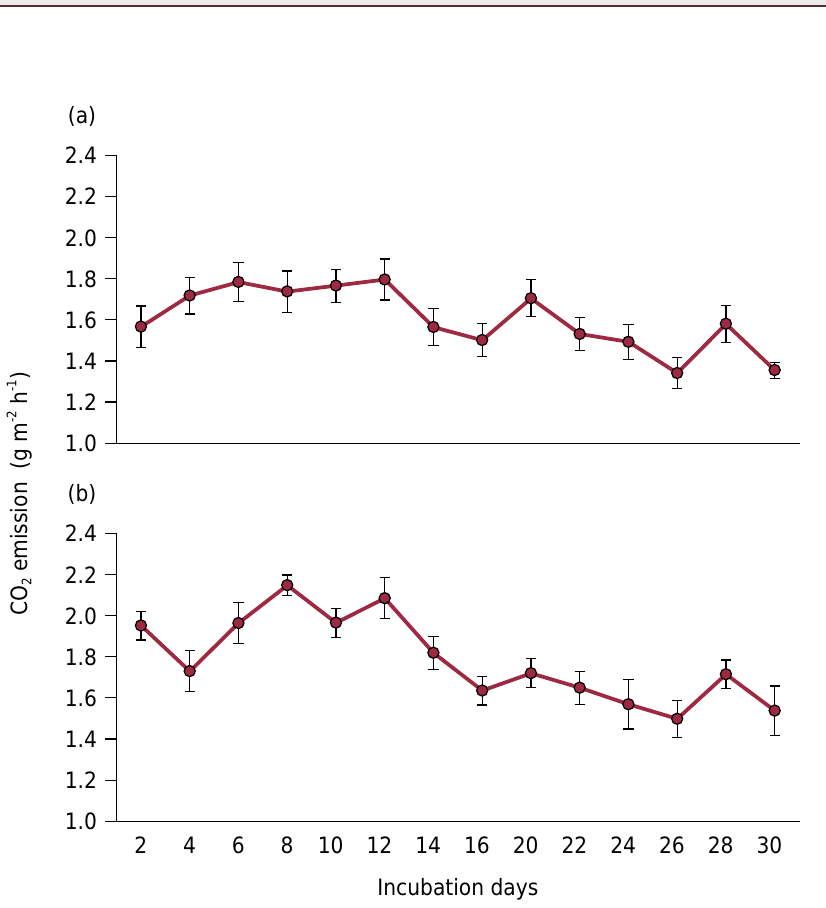
Figure 3. Average CO 2 emission rate under 15 % (a) and 30 % (b) moisture treatments for a calcareous soil in the Comarca Lagunera,